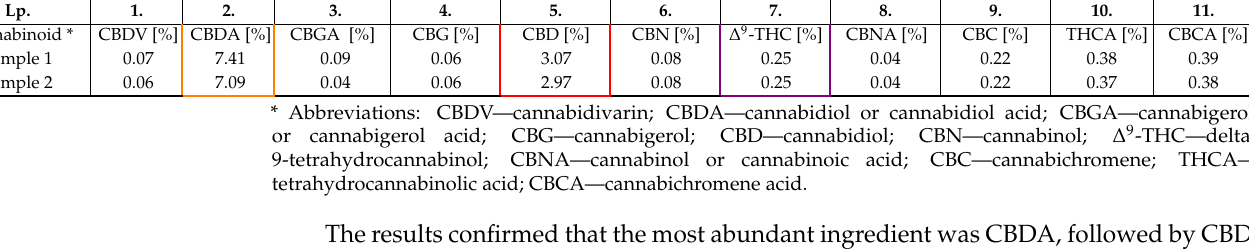
Table 1. Percentage of individual cannabinoids in the cannabis samples (based on Supplementary Materials, Figures S1 and S2).